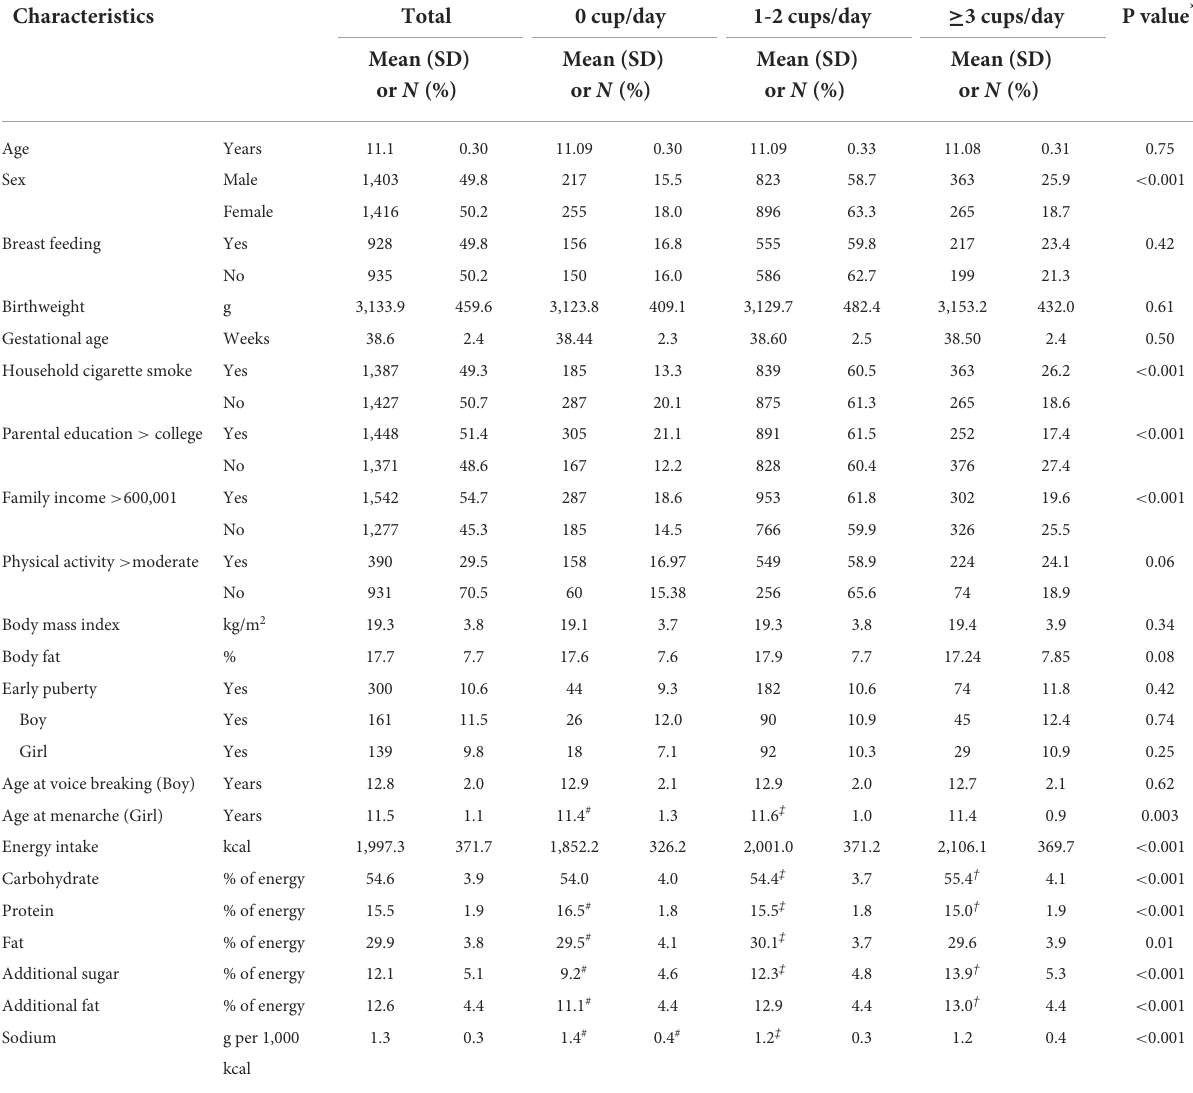
TABLE 1 Baseline characteristics according to categories of sugar-sweetened beverages in Taiwanese children at 11 years ( N = 2,819).